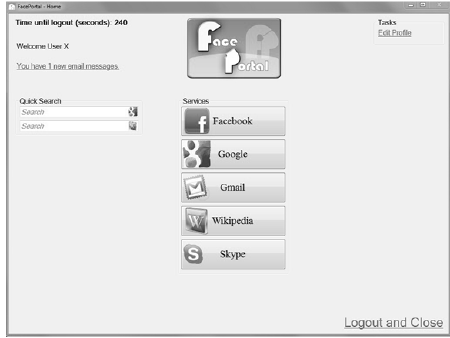
FIGURE 3: SENPORTAL HOME